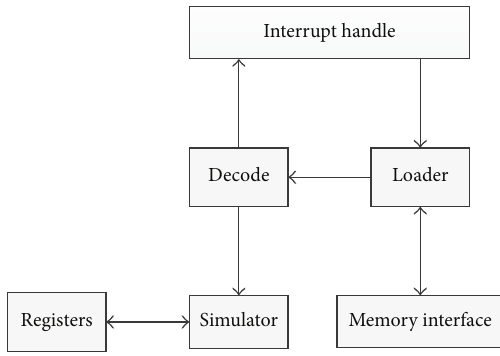
Figure 2: Block diagram of